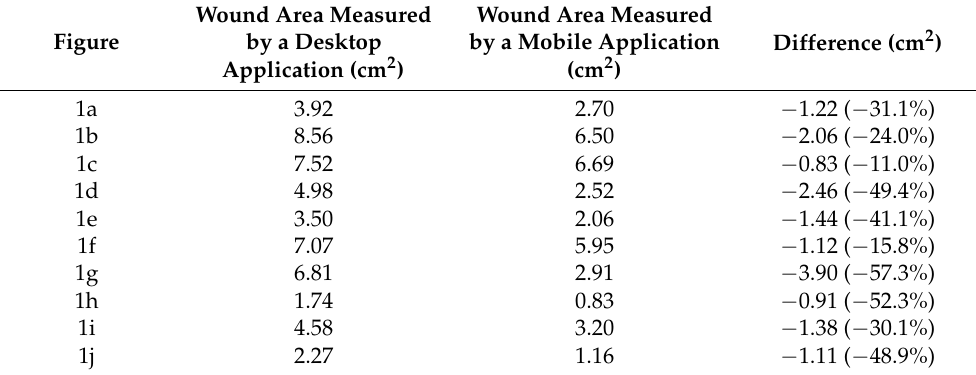
Table 5. Comparison of the wound area measured by the different platforms.